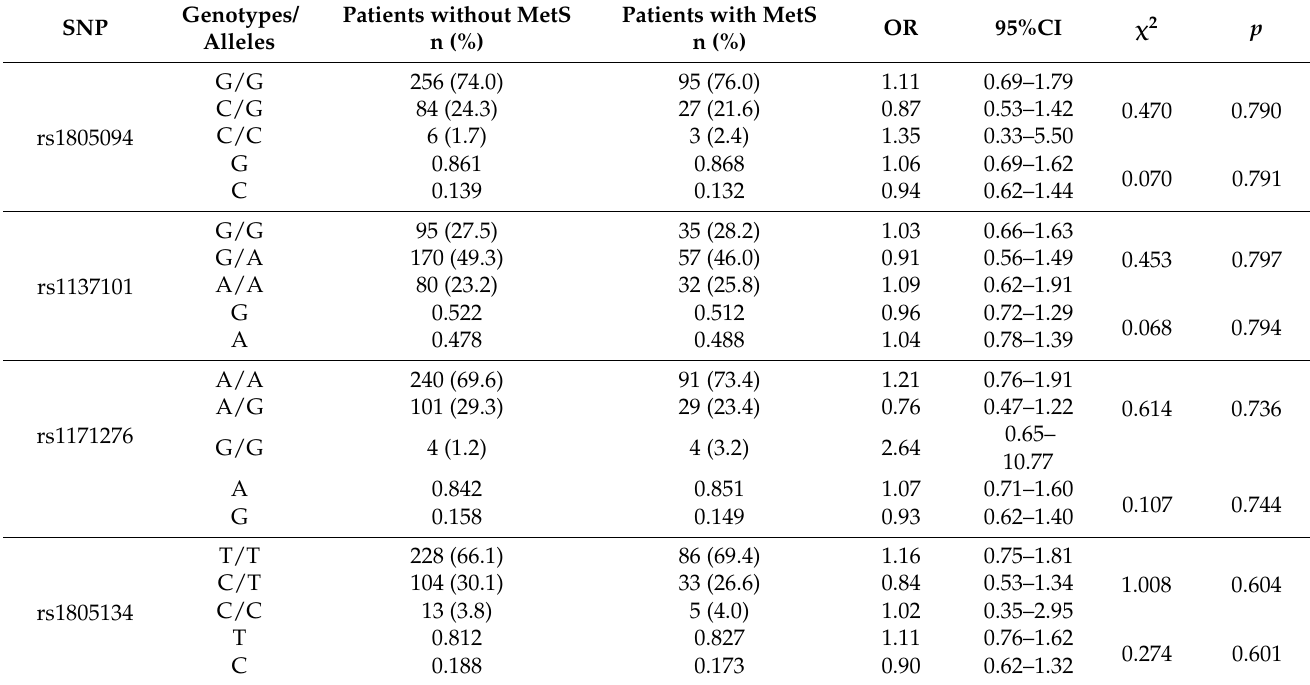
Table 4. Distribution of alleles and genotypes of LEPR polymorphisms in groups of patients.